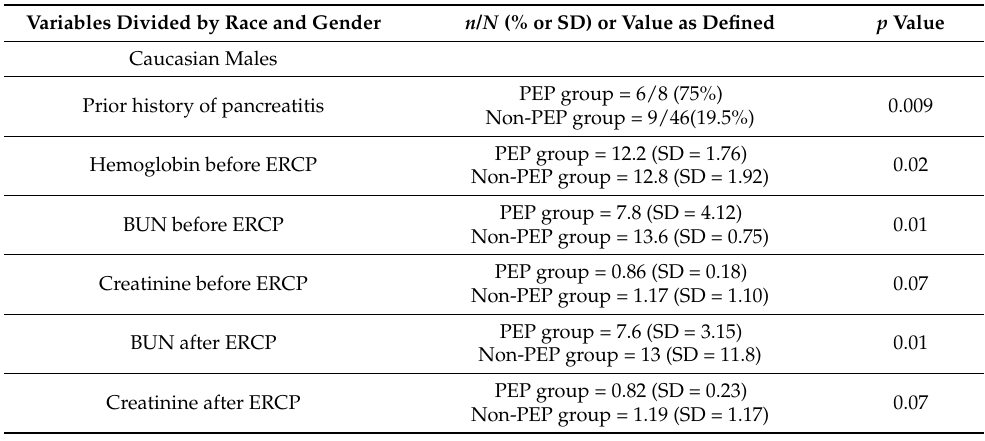
Table 3. Univariate analysis of potential risk factors for post-endoscopic retrograde cholangiopancre- atography (ERCP) pancreatitis